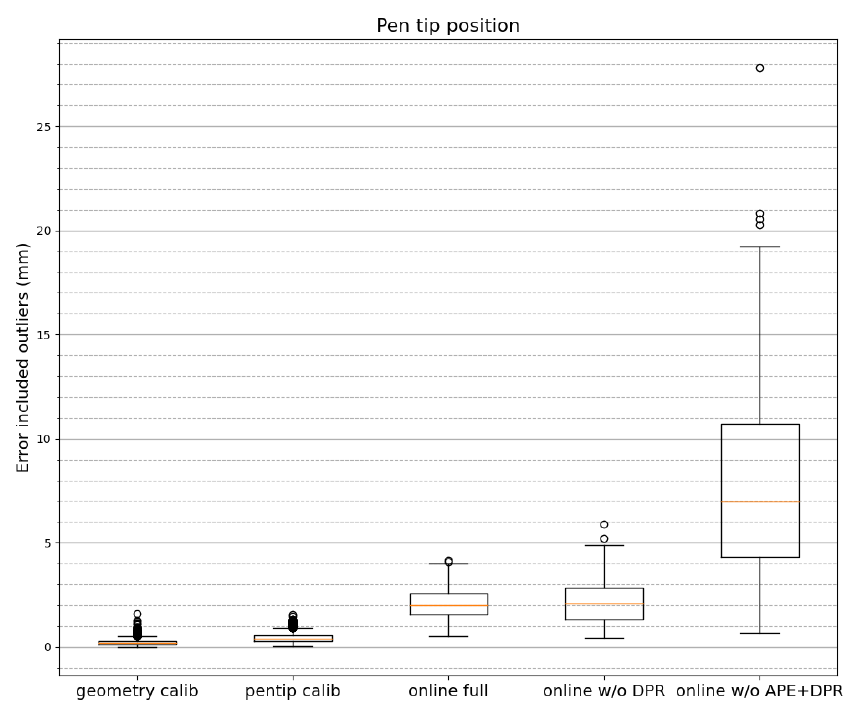
Figure 13. Distribution of residuals in different mode of operations. The first two boxes show the residuals of an offline calibration. The remaining three boxes show the norm errors of an online execution at different operation modes. To facilitate an experiment with ground-truth for error calculation, this online execution is collected from an experiment with ChArUco